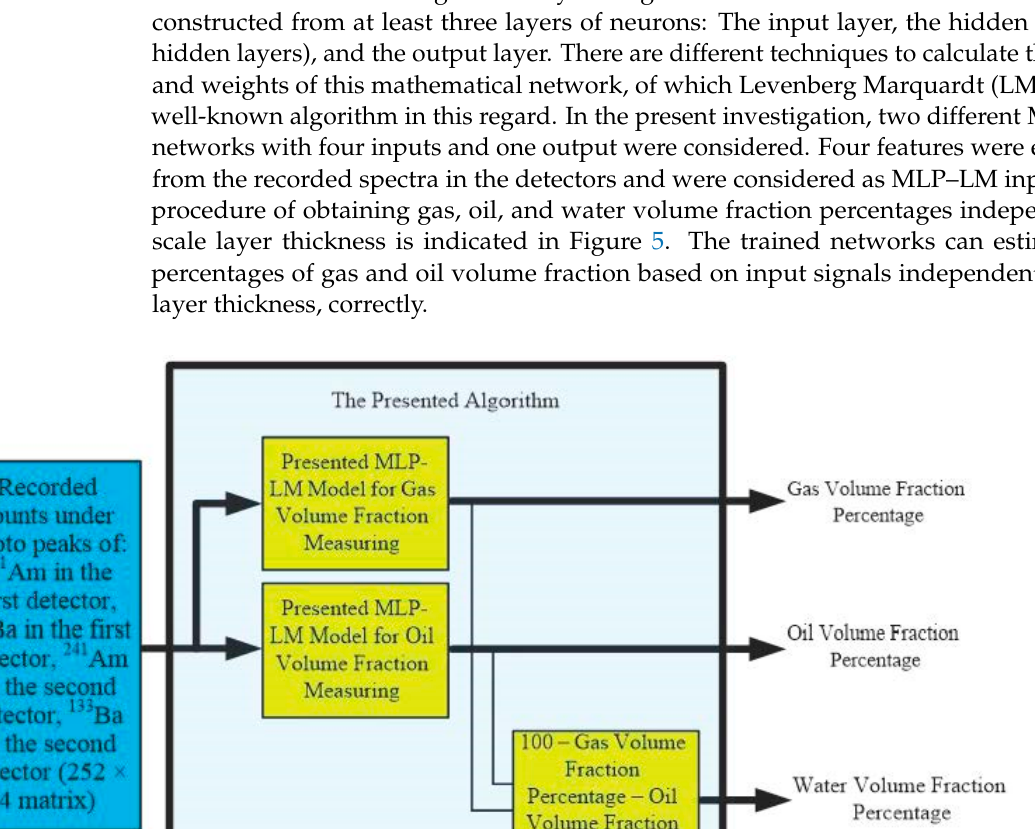
Figure 5. The procedure of obtaining gas, oil, and water volume fraction percentage in a three-phase flow independent of scale layer thickness.